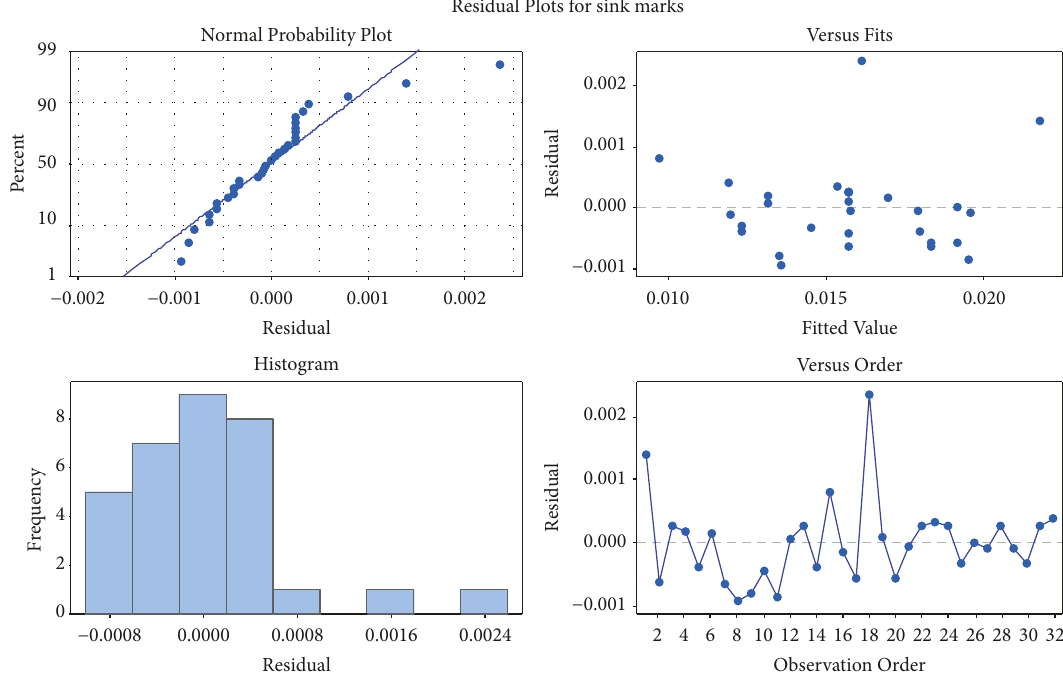
Figure 10: Residuals between the predicted and experimental